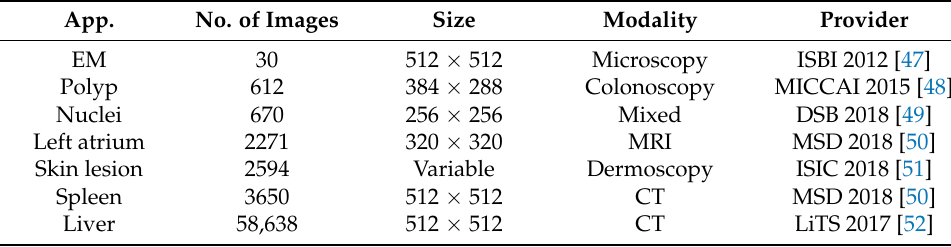
Table 2. The details of the datasets are used in our experiments.